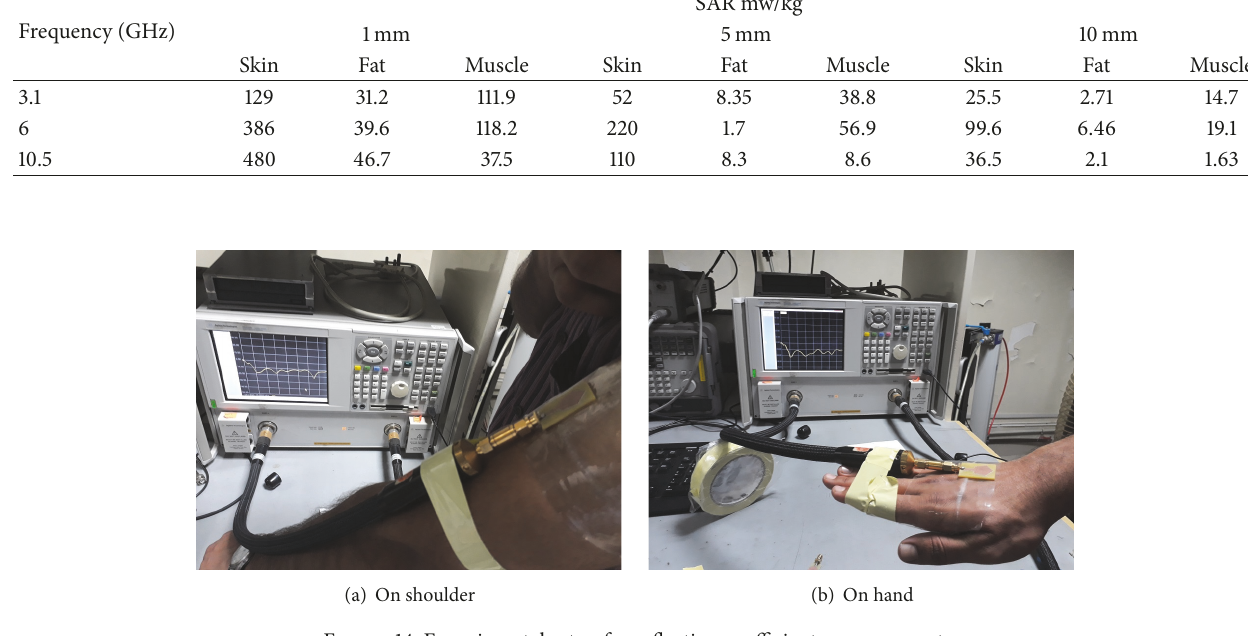
Figure 14: Experimental setup for reflection coefficient measurement.